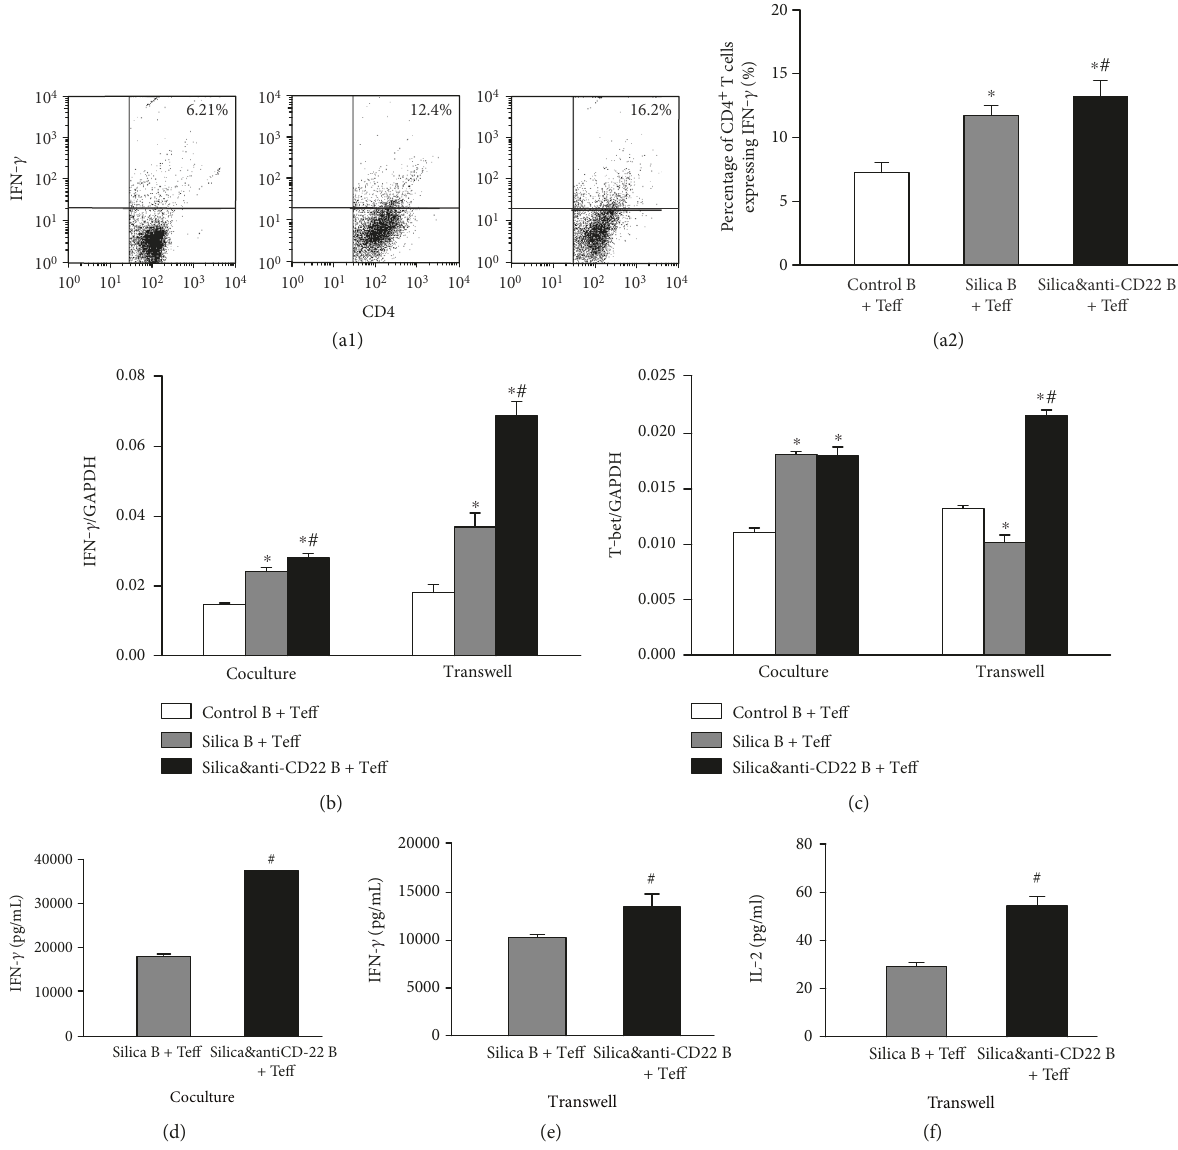
Figure 2: Insu ffi cient B10 aggravated the Th1 response in the Te ff and B cell coculture system in vitro. (a1, a2) The percentages of CD4 + IFN- γ + Th1 cells in di ff erent groups of the B cell and Te ff coculture system were studied by fl ow cytometry. (b, c) The expressions of IFN- γ and T-bet in di ff erent groups of the B cell and Te ff coculture system with or without insert plates were assayed by real-time PCR. (d) The secretions of IFN- γ in supernatant of the B cell and Te ff coculture system were assayed by CBA. (e, f) The concentrations of IFN- γ and IL-2 in supernatant of the B cell and Te ff coculture system with insert plates were assayed by CBA. (Data was presented as mean ± SEM ( n = 5 ). ∗ p < 0 05 , signi fi cantly di ff erent compared with the control B+Te ff group. # p < 0 05 , signi fi cantly di ff erent compared with the silica B+ Te ff